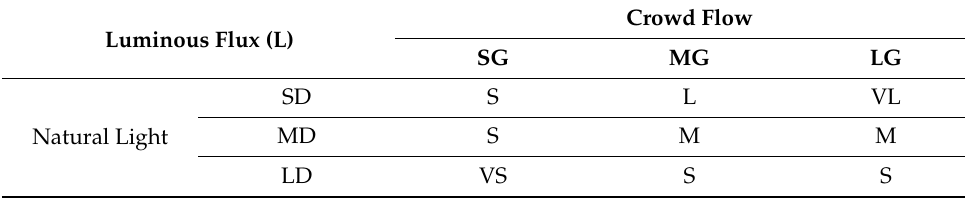
Table 1. Fuzzy rule distribution.